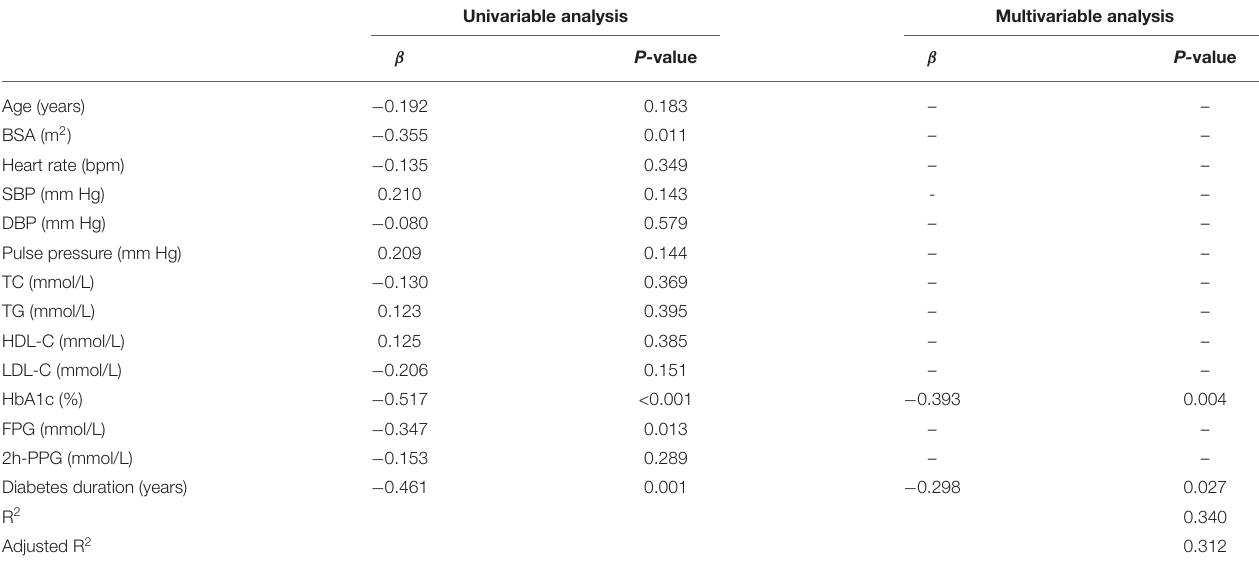
TABLE 5 | Univariable and multivariable linear regression analysis of GCW in T2DM patients.